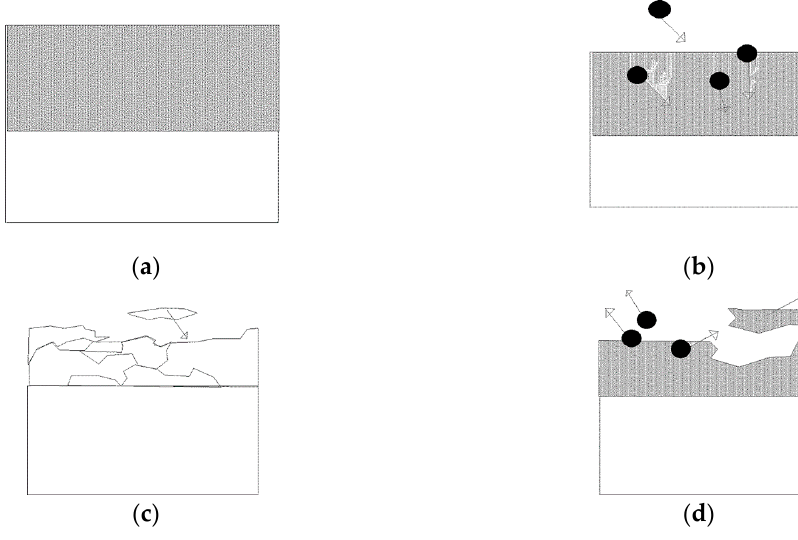
Figure 21. The four basic categories of tribological surface modification: ( a ) modification without any material transfer; ( b ) modification involving material transfer; ( c ) formation of tribofilm or coating; and ( d ) wear (loss of particles or atoms from the surface) [58].